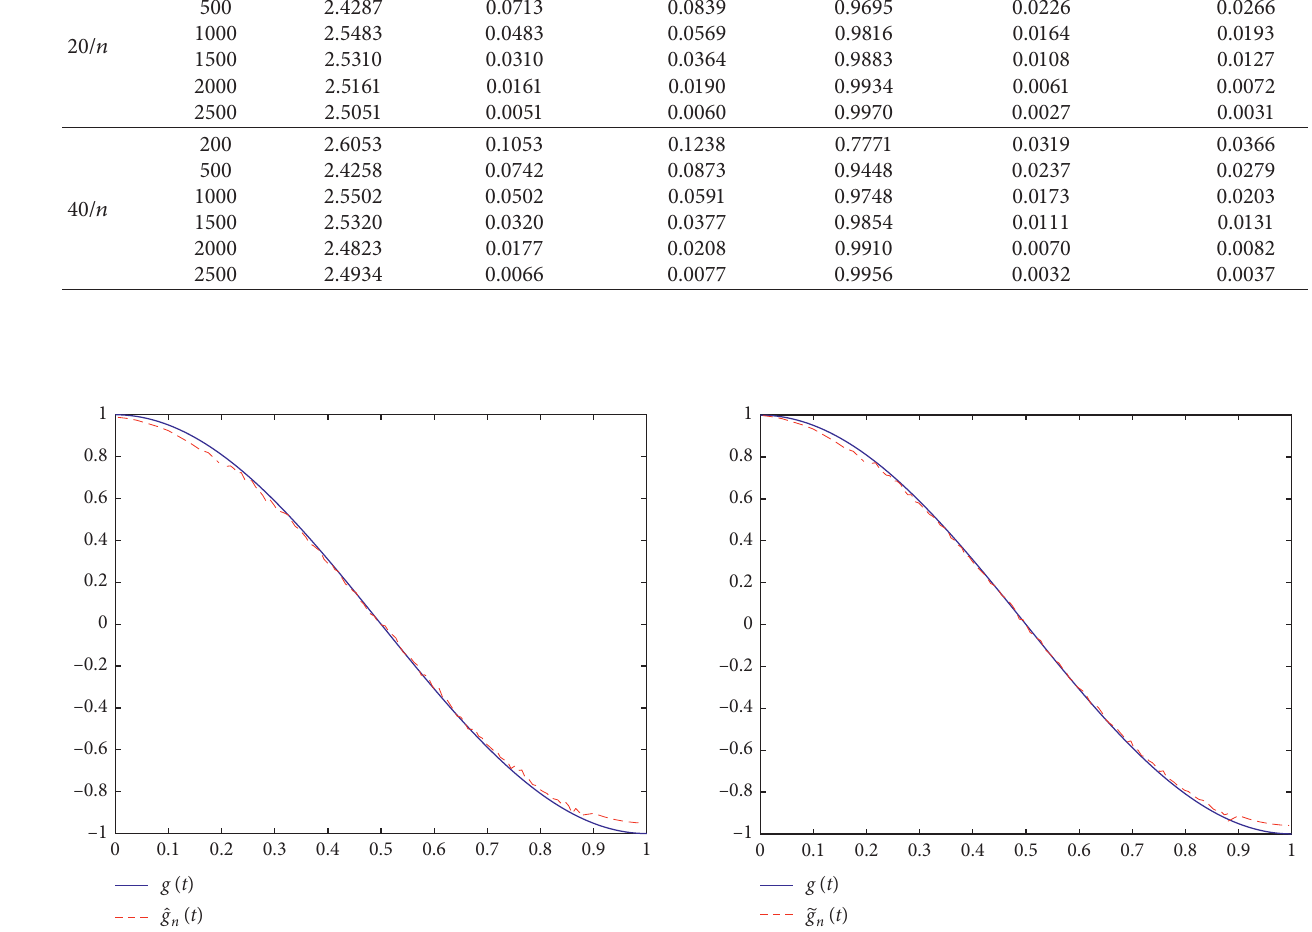
( t ) with β � 2 . 5 and n